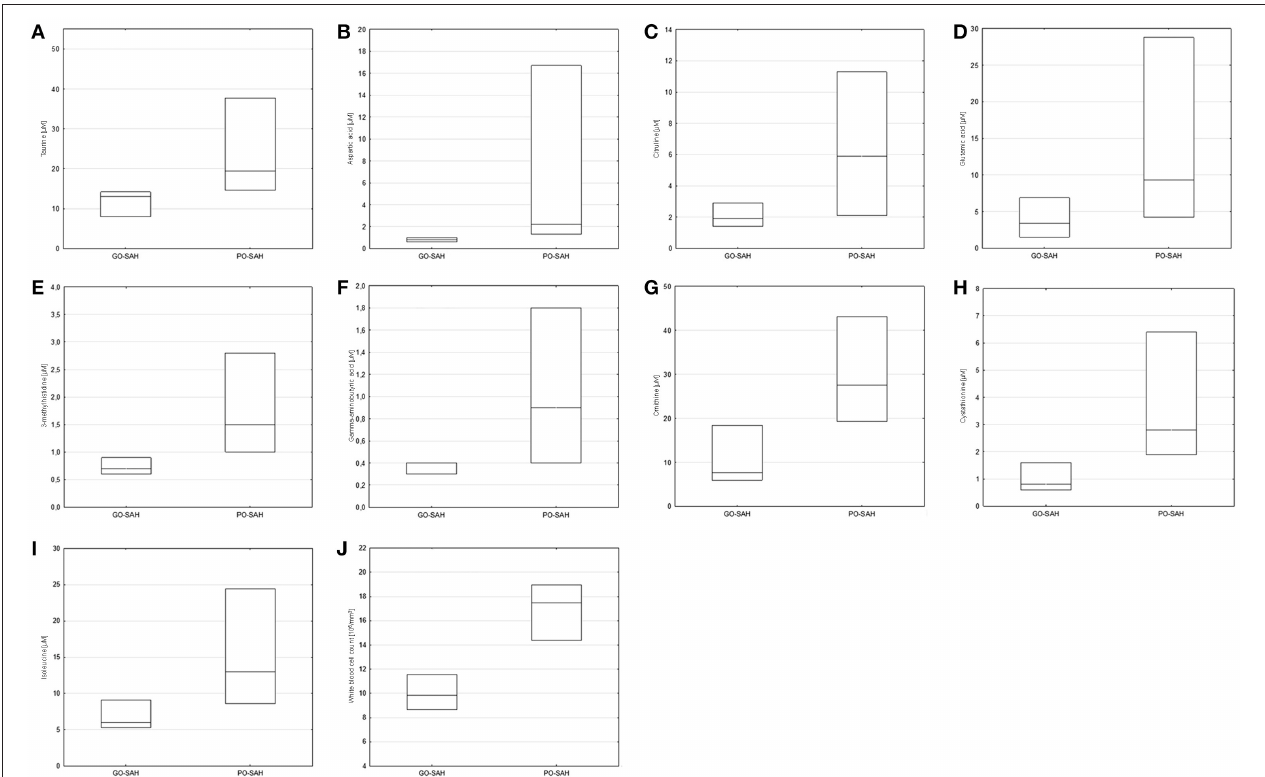
FIGURE 1 | Significant differences in monitored parameters on day 0–3 post-SAH between patients with good (GO-SAH) and poor (PO-SAH) treatment outcome. Mann–Whitney test revealed significantly higher levels of: (A) taurine ( p = 0.038), (B) aspartic acid ( p = 0.038), (C) citruline ( p = 0.035), (D) glutamic acid ( p = 0.038), (E) 3-methylhistidine ( p < 0.01), (F) gamma-aminobutyric acid ( p = 0.043), (G) ornithine ( p = 0.033), (H) cystathionine ( p < 0.01), (I) isoleucine ( p = 0.045) in patients with poor outcome. T -Student test revealed significantly higher level of white blood cell count ( p < 0.01) in patients with poor outcome (J) . In all cases median levels and the 25th and 75th percentile are presented.